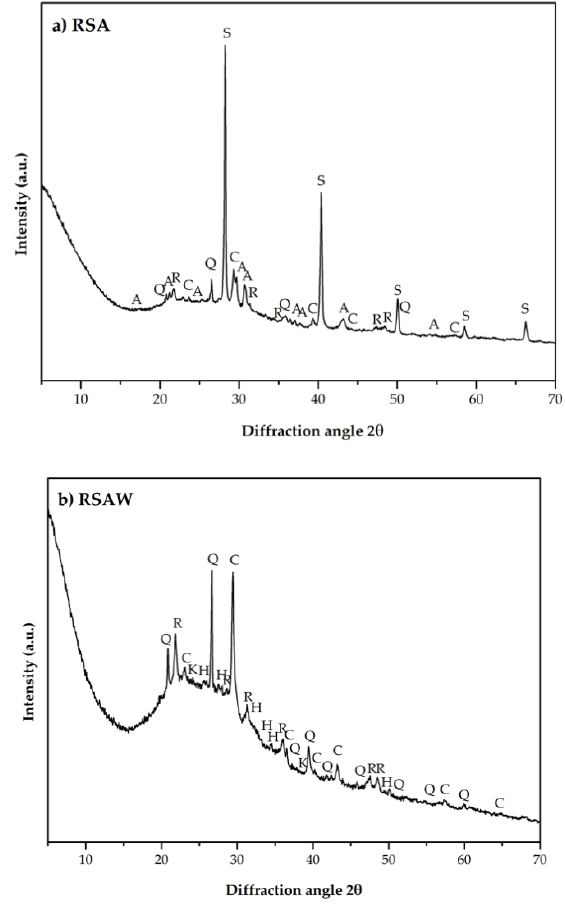
Figure 4. XRD diffractograms: ( a ) RSA and ( b ) washed RSA (RSAW).